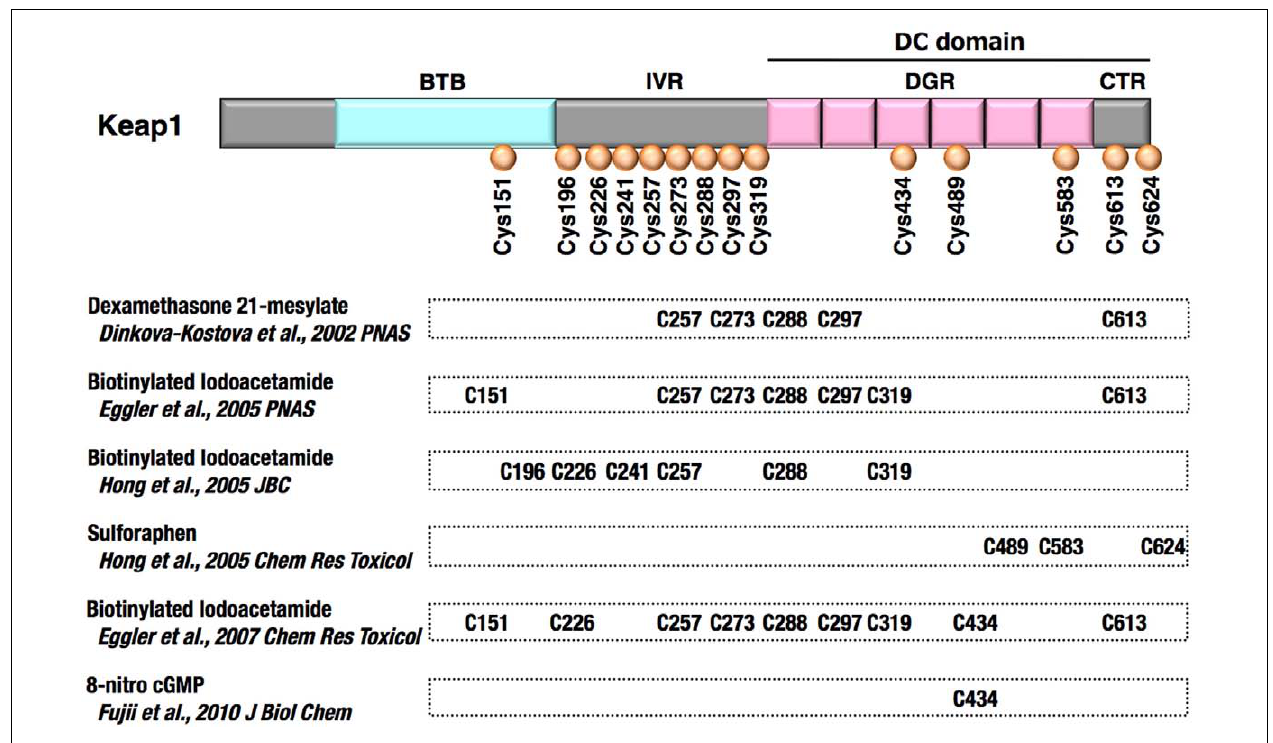
FIGURE 2 | Keap1 is a thiol-rich protein that is sensitive to electrophilic covalent modification. Domain structure of Keap1 is shown, and reactive cysteine residues are indicated with brown circles. Direct modification of cysteine residues was demonstrated using various electrophiles. Each electrophile attacks a unique set of